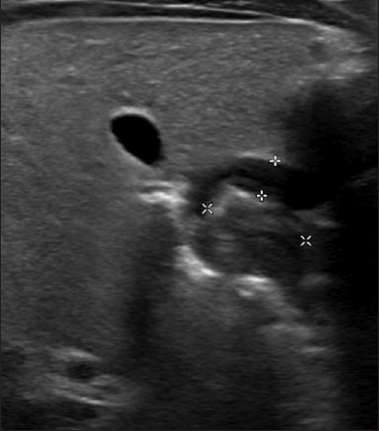
Figure 2: Ultrasound confirming hypertrophic pyloric stenosis, with measurement of 5 mm thickness and 13 mm